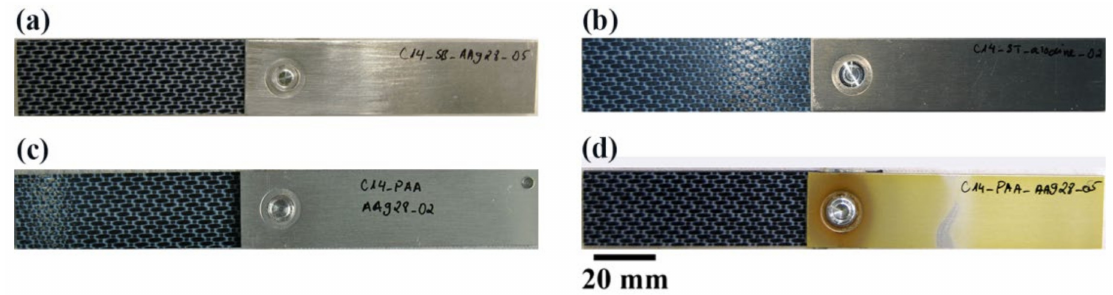
Figure 2. Top view of the SLS FSp joints prior to aging; ( a ) SB, ( b ) CC, ( c ) PAA, and ( d ) PAA-P.